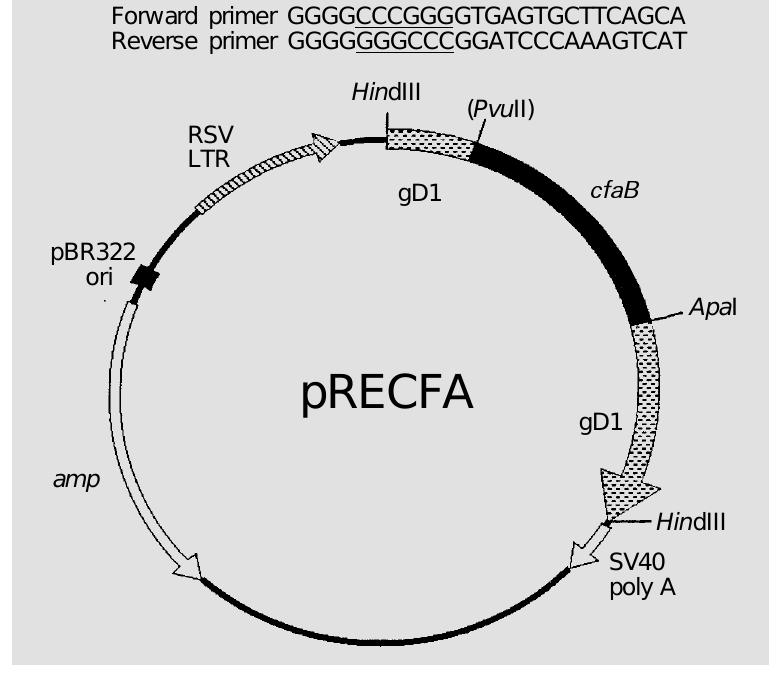
Figure 1 - Schematic representation of pRECFA. Forward and reverse primers containing restriction sites (underlined sequences) for Sma I and Apa I, respectively, were used to amplify a synthetic gene encoding the mature CFA/I subunit ( cfaB ). The pRE4 was digested with Pvu II and Apa I restriction enzymes and the internal 650-bp fragment of the HSV gD1- encoding gene was removed. The cfaB gene, obtained after cleavage of the PCR-generated fragment with Sma I and Apa I, was then cloned in frame with the remaining HSV gD1- encoding gene. The original Pvu II site of pRE4 was lost during the construction of the recombinant plasmid (marked by brackets). The encoded hybrid protein contained the signal peptide, the first 27 N-terminal and the last 71 C-terminal amino acids of the HSV gD1 protein besides the complete amino acid sequence of the CFA/I subunit (147 amino acids). RSV, Rous sarcoma virus; LTR, long terminal